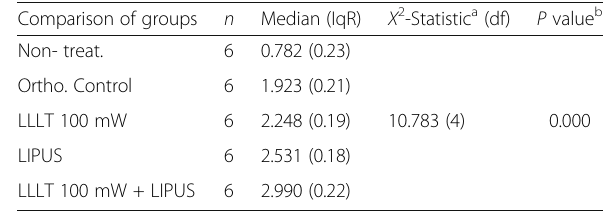
Table 5 Comparison of median of OPG gene expression levels among the study groups at day 21 Comparison of groups